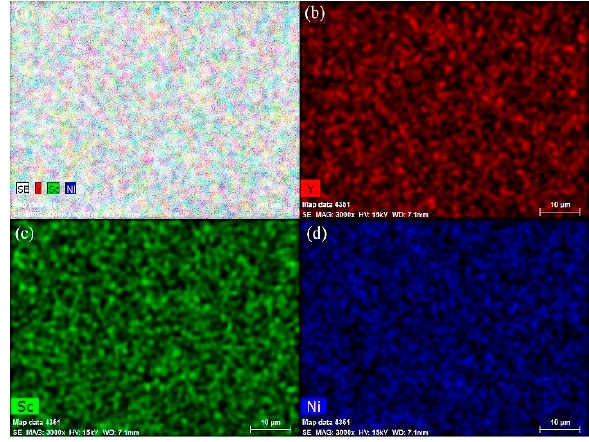
Figure 2. EDS elemental mapping ( a – d ) of as-annealed Y 0.25 Sc 0.7 Ni 2 . Table 1. Structural parameters of Y 0.95– x Sc x Ni 2 compounds.